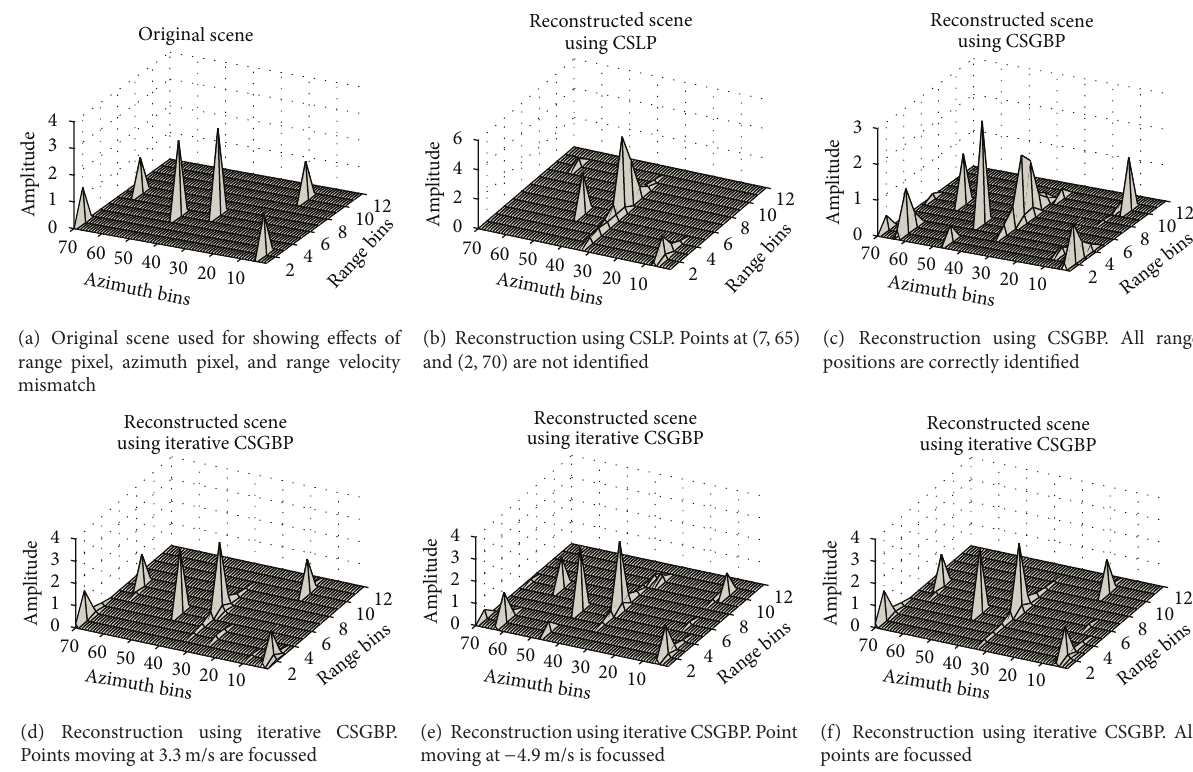
Figure 9: Reconstruction using CSLP, CSGBP, and iterative